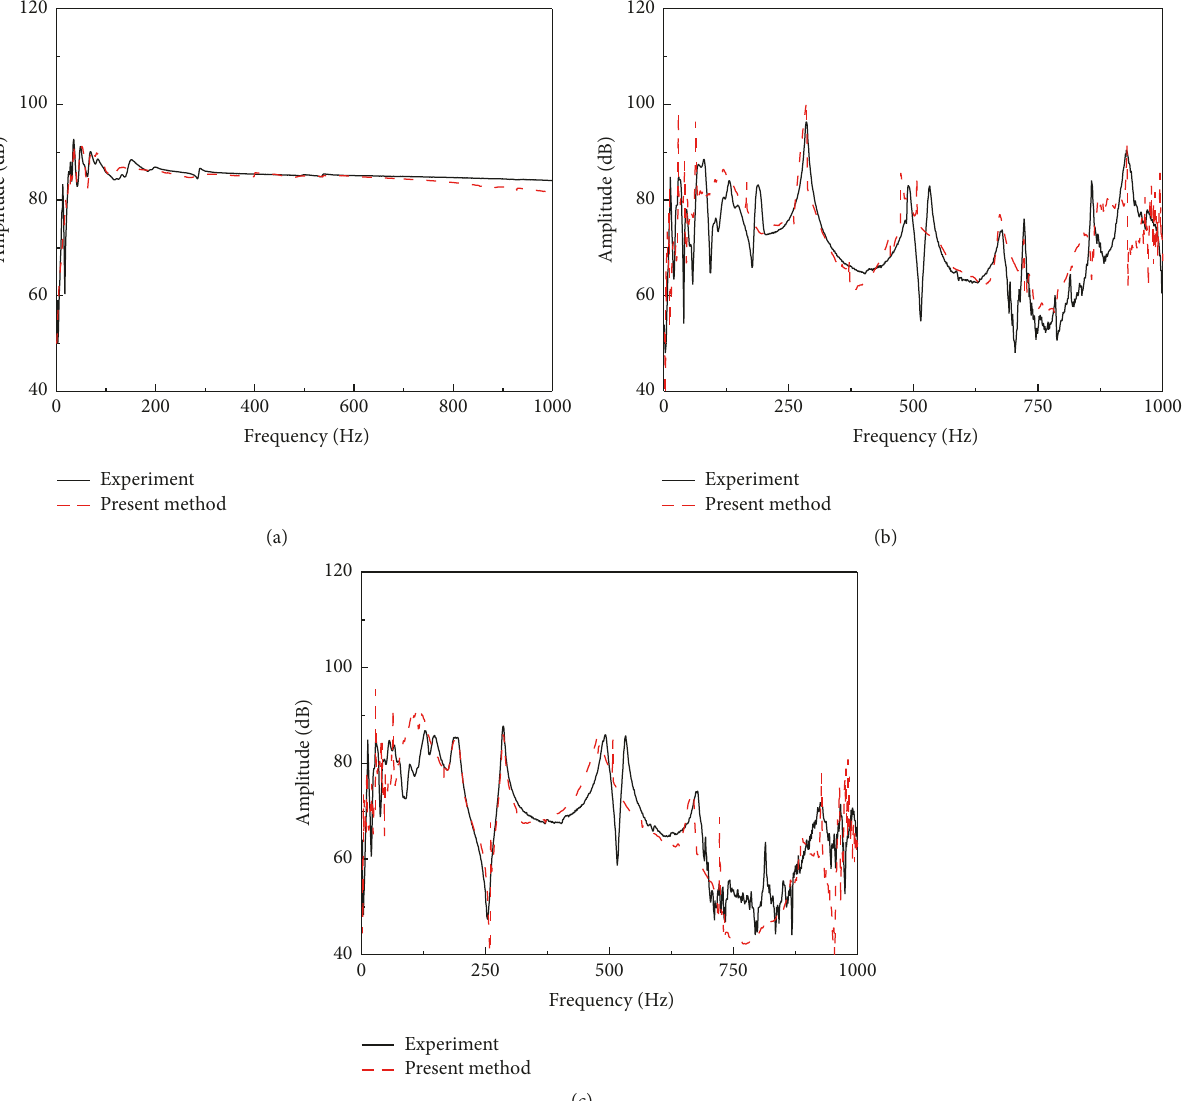
Figure 7: Comparison of the measured FRFs and the synthesis results for floating raft system without attached pipes: (a) driving FRF of the exciting point; (b) transfer FRF from exciting point to one point on top surface of the raft; (c) transfer FRF from exciting point to one point on bottom surface of the raft.